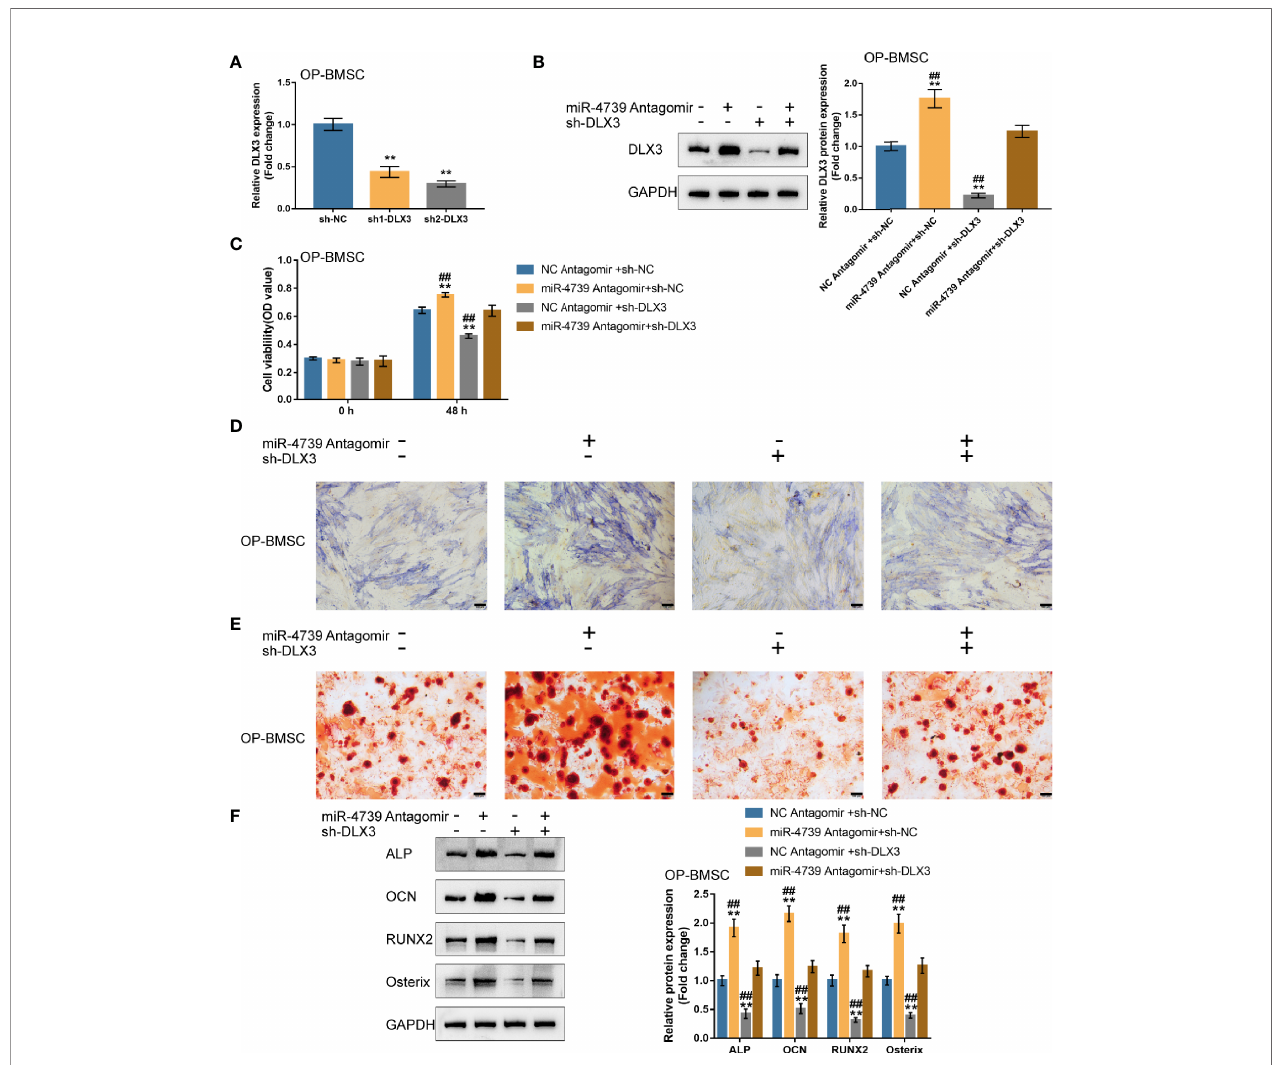
FIGURE 6 | Co-effects of the miR-4739/DLX3 axis on osteoporotic BMSC osteogenic differentiation (A) DLX3 knockdown was achieved in osteoporotic BMSCs by transfecting short hairpin RNA against DLX3 (sh1/2-DLX3); DLX3 knockdown was con fi rmed by qRT-PCR. n=3. Then, osteoporotic BMSCs were co-transfected with sh-DLX3 and antagomir-4739 and examined for the protein levels of DLX3 by Immunoblotting (B) and cell viability by CCK-8 assay (C) (n=3). Then, normal BMSCs were co-transfected with sh-DLX3 and antagomir-4739, induced towards osteogenic differentiation for 21 days, and examined using ALP staining on day 14 of osteogenic induction (D) ; the formation of mineralized nodules using Alizarin red staining on day 21 of osteogenic induction (E) ; the protein levels of ALP, OCN, Runx2, and Osterix using Immunoblotting on day 14 of osteogenic induction (F) . n=3. ** P < 0.01, ## P <